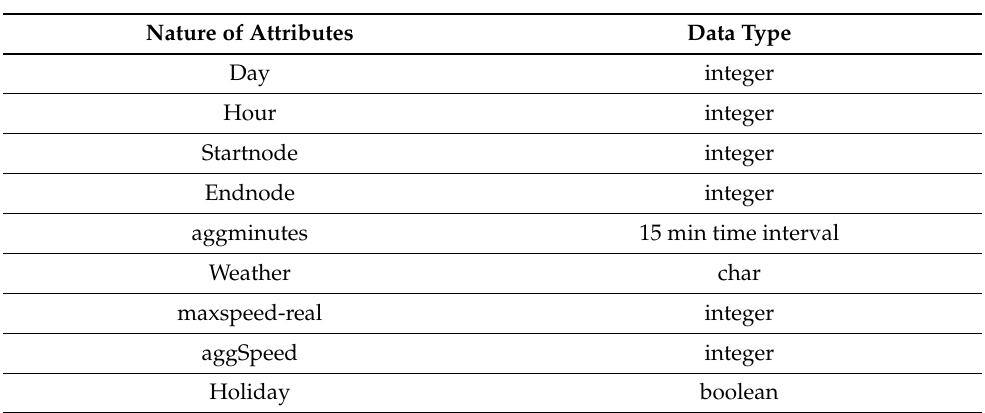
Table 1. Hybrid Feature Space. Nature of